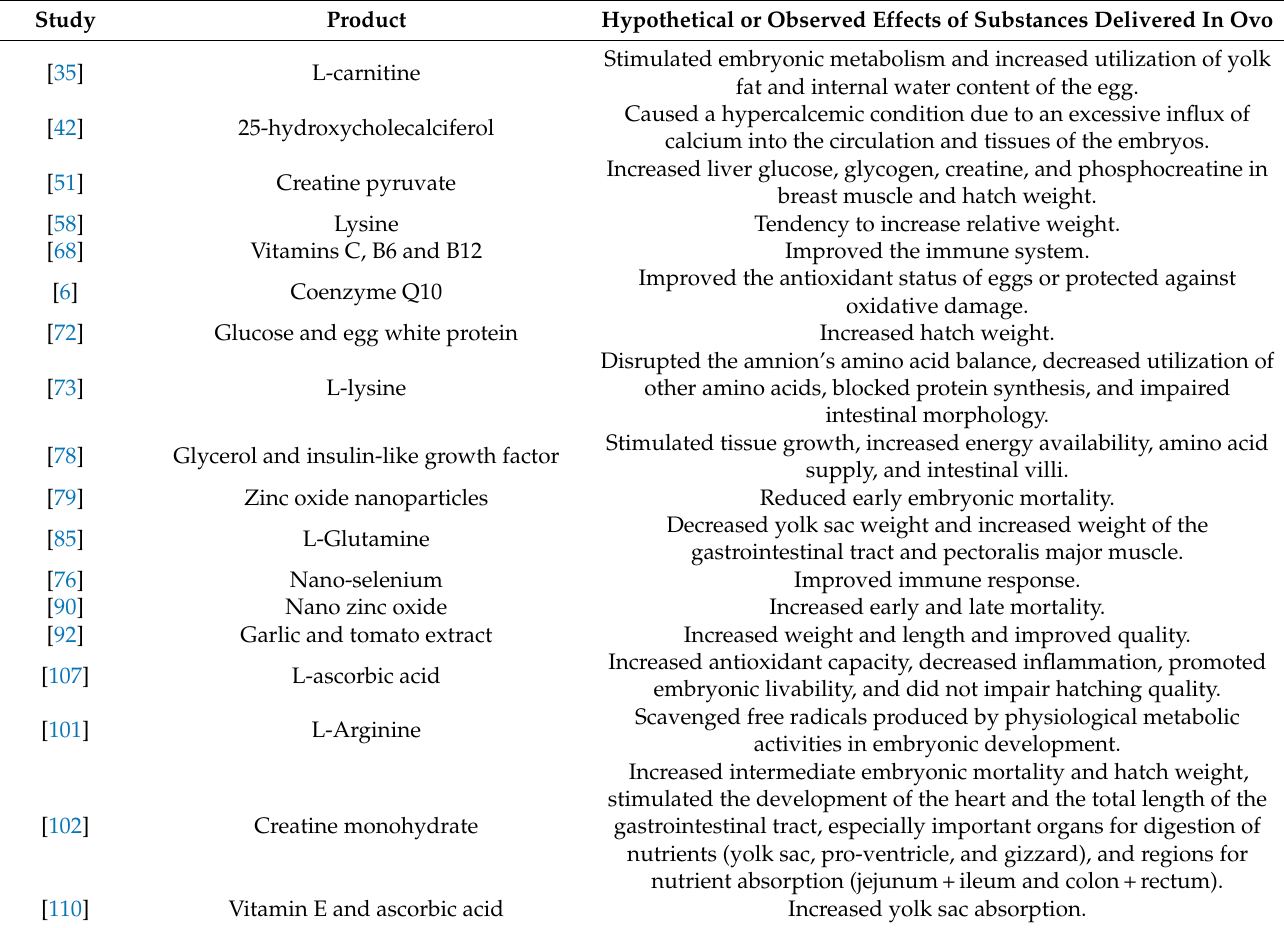
Table 5. Effects of substances delivered in ovo on developing poultry including the early stages after